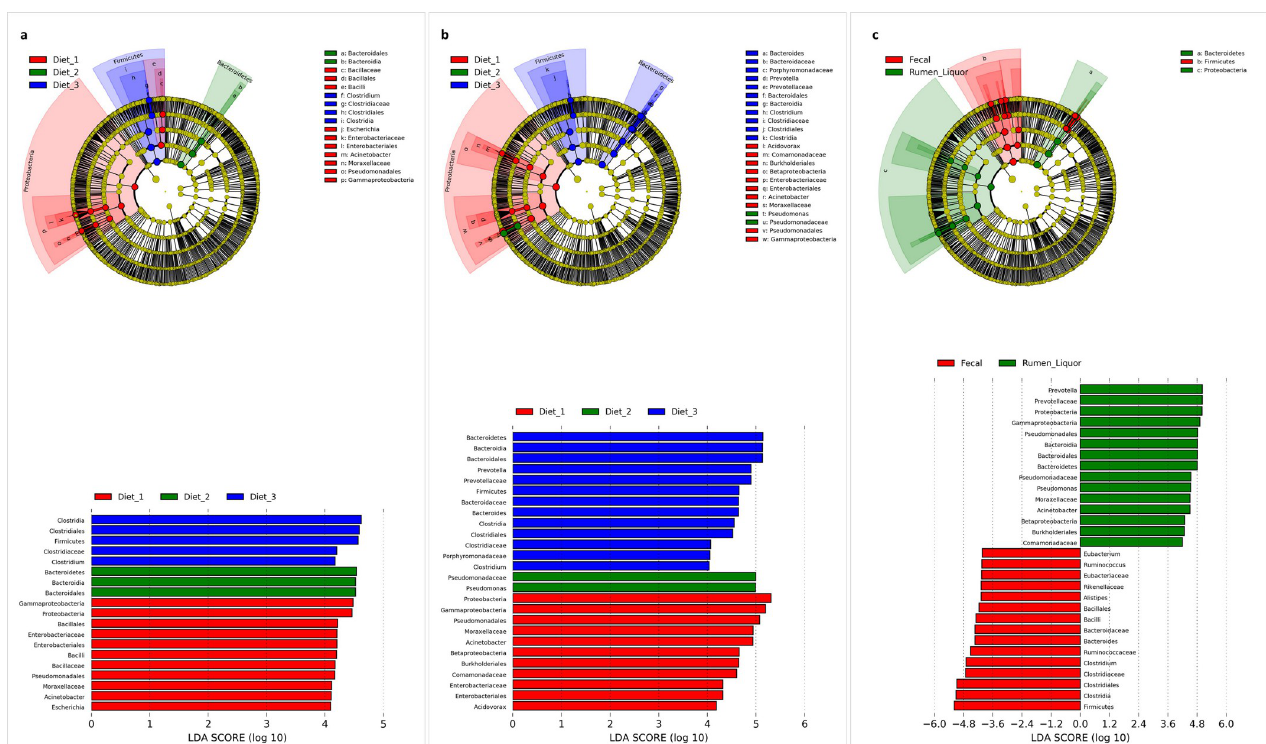
Fig 4. Cladograms and histograms illustrating significantly different microbial taxa in LEfSe analysis. a . Diets within fecal sample type, b . Diets within rumen liquor sample type, c . Fecal and rumen liquor sample types. The cladogram illustrates the presence of microbial phyla and genera that are significantly different based on linear discriminant analysis (LDA) scores in the histogram. The LDA score at log 10 > 4 is set as threshold and the length of each bin, i.e., LDA score represents the extent to which the microbial taxa differ among the groups.